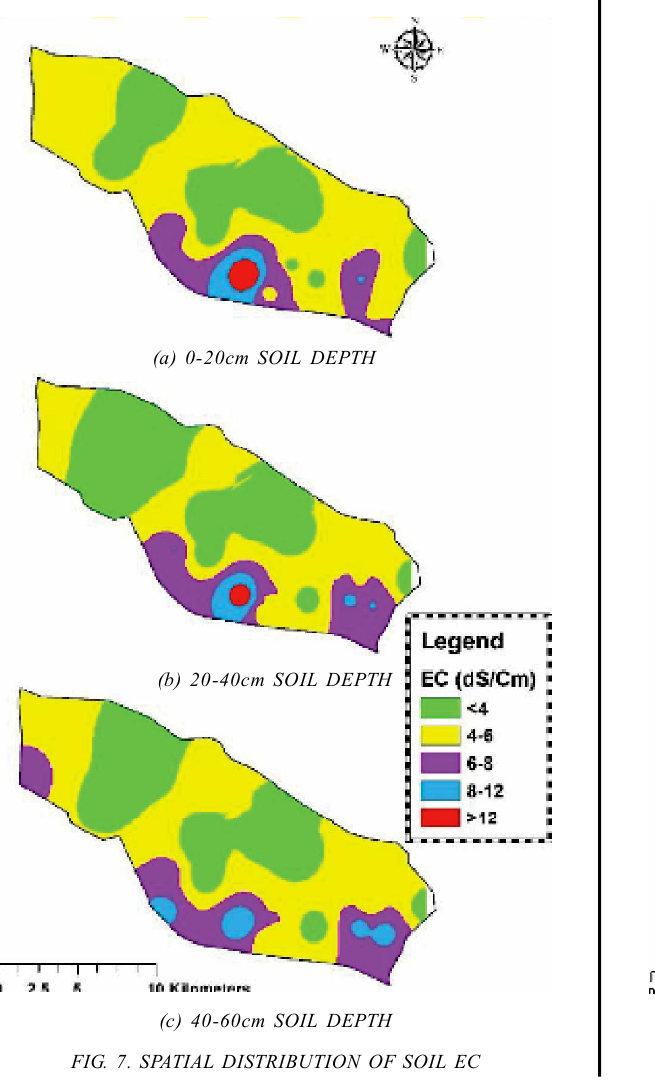
FIG. 9. SPATIAL DISTRIBUTION OF SOIL